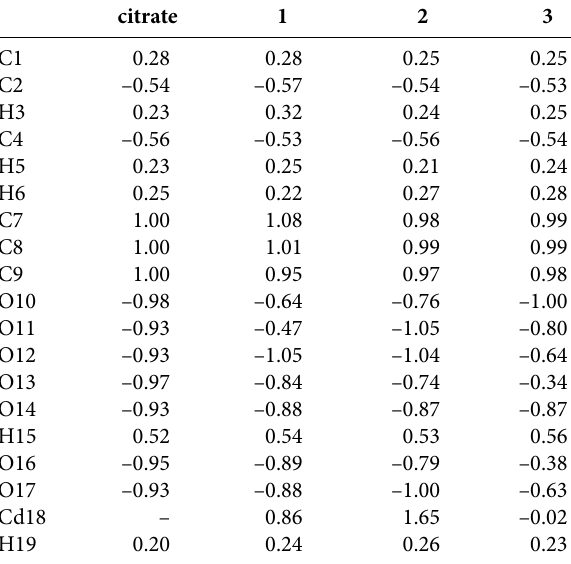
Table 3. NBO charges in a.u. for citrate ion and systems 1–3.